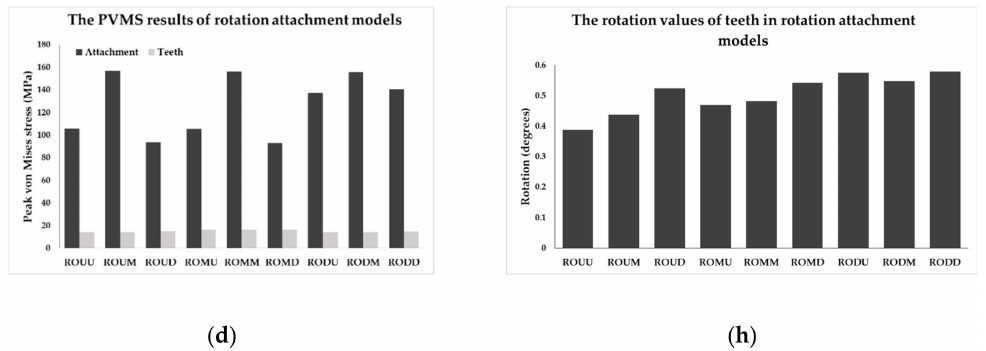
Figure 9. The PVMS values of ( a ) extrusion; ( b ) intrusion; ( c ) torque; and ( d ) rotation attachments; The displacement of ( e ) extrusion; ( f ) intrusion; ( g ) torque attachments; The rotation of ( h ) rotation